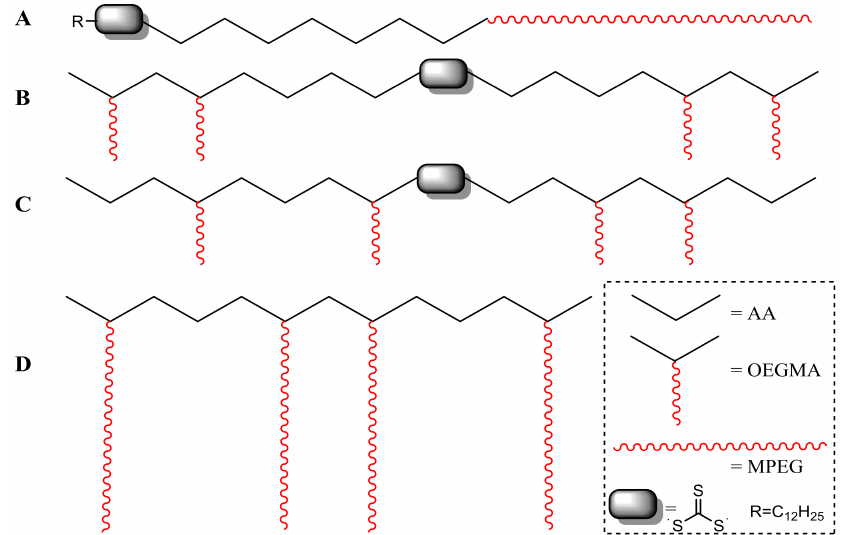
Figure 8. Polymer stabilizers used for the calcite nanoparticles (CCNPs): ( A ) poly(AA- b -MPEG); ( B ) poly(OEGMA- b -AA- b -OEGMA); ( C ) poly(AA- r -OEGMA); ( D ) PCA1, a developmental poly(AA- r -PEGMA) from BASF (Treviso,